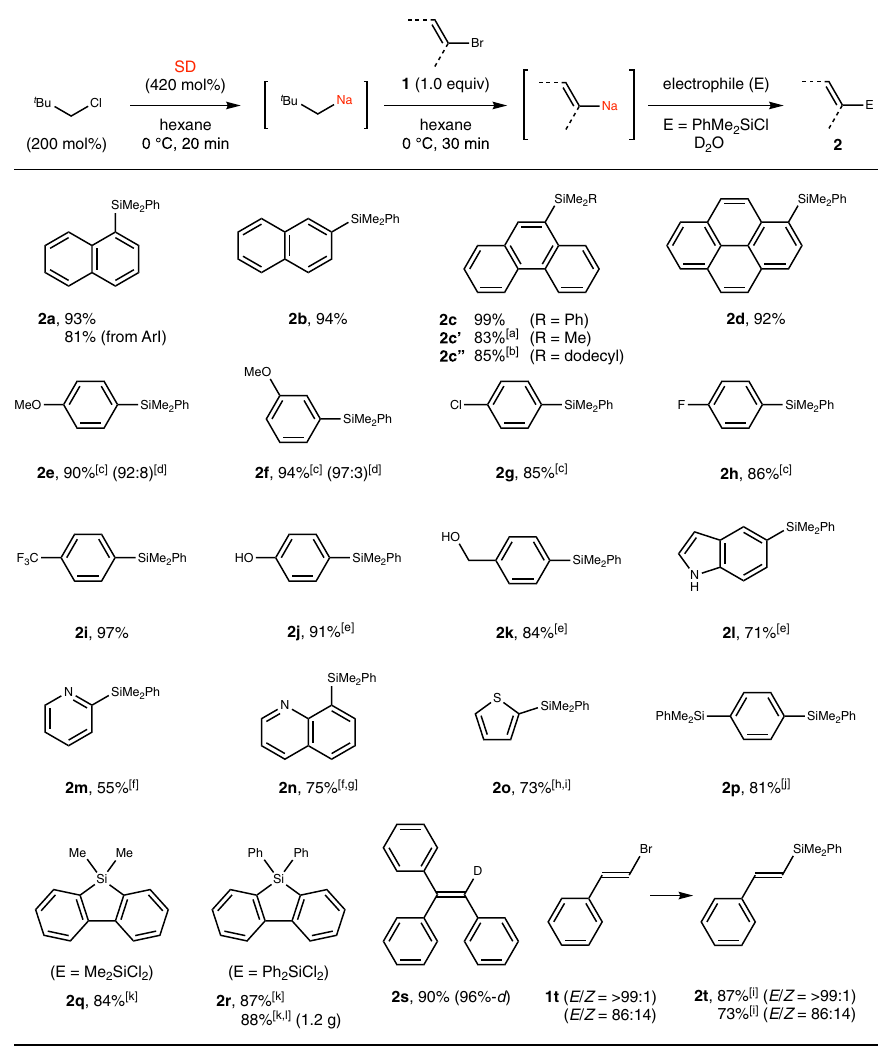
Fig. 3 Halogen – sodium exchange between aryl and alkenyl halides and neopentylsodium. Neopentylsodium prepared in situ from neopentyl chloride (200 mol%) and SD (420 mol%) was reacted with organic halides ( 1 , 0.25 mmol) in hexane (2.0 mL) at 0 °C, followed by addition of R 3 SiCl (1.2 equiv), R 2 SiCl 2 (2.0 equiv), or D 2 O (1.0 mL) as an electrophile. Yields determined by isolation are shown unless otherwise noted. Deuterium content was determined by 1 H NMR. a Me 3 SiCl (1.2 equiv). b (Dodecyl)Me 2 SiCl (1.2 equiv). c Exchange reaction at – 40 °C for 10 min. d Ratio of monosilylated and disilylated products were determined by 1 H NMR. e Neopentyl chloride (300 mol%), SD (630 mol%), hexane (2.5 mL), and PhMe 2 SiCl (3.0 equiv); after reaction, the concentrated crude mixture was reacted with K 2 CO 3 (5.0 equiv) in MeOH (3.0 mL) for 1 h. f Exchange reaction at – 78 °C. g THF (0.80 mL) was used as a co-solvent. h Neopentyl chloride (120 mol%) and SD (250 mol%). i Exchange reaction for 10 min. j Neopentyl chloride (300 mol%), SD (630 mol%), hexane (2.5 mL), and PhMe 2 SiCl (3.0 equiv). k Neopentyl chloride (340 mol%), SD (710 mol%), hexane (2.5 mL), and R 2 SiCl 2 (2.0 equiv).